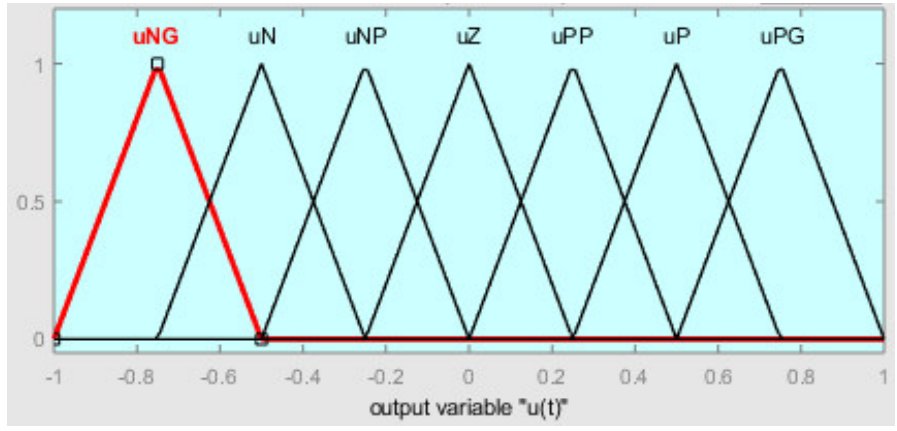
Figure 15. Membership functions and universe of discourse of the control output signal.